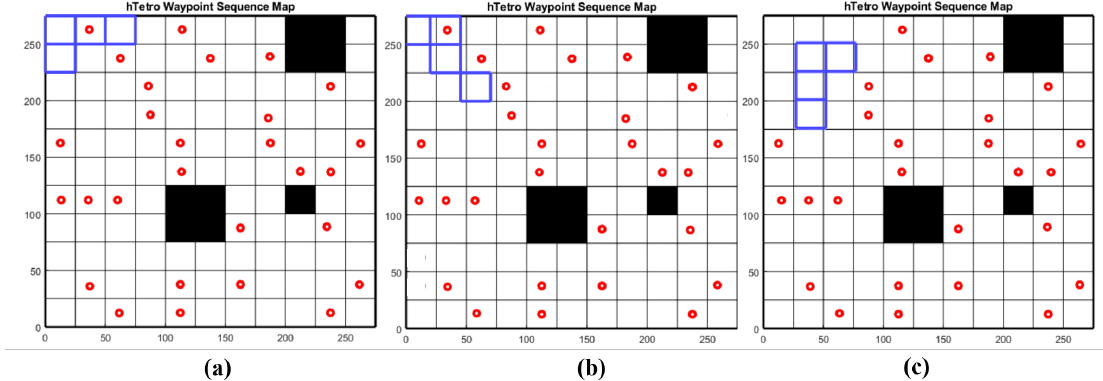
Figure 17. Simulation workspace environment. ( a ) Robot at first waypoint; ( b ) Robot transformation on workspace; ( c ) Robot navigate to clear the next